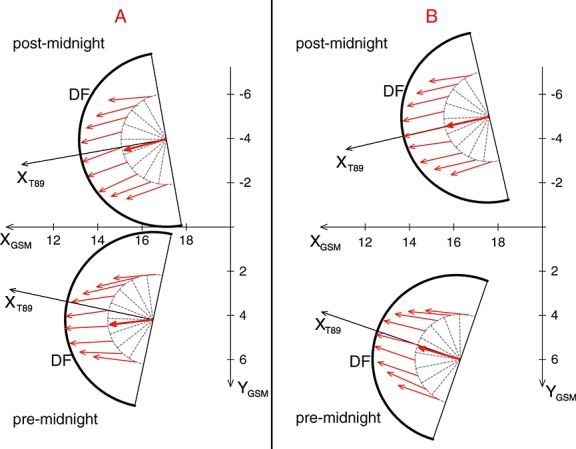
Sketch of the assumed propagation direction of the DF (XT89) and the maximum plasma flow direction in XY plane. The red arrows represents the direction of Vxy, max, estimated from the least squares fit of Figure 5. The thick red arrow in the DF center is the average flow direction.